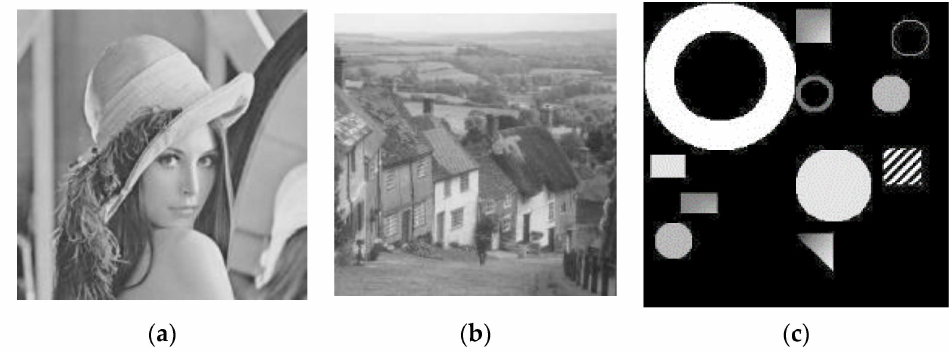
Figure 1. Test images. ( a ) Lenna. ( b ) Goldhill. ( c )